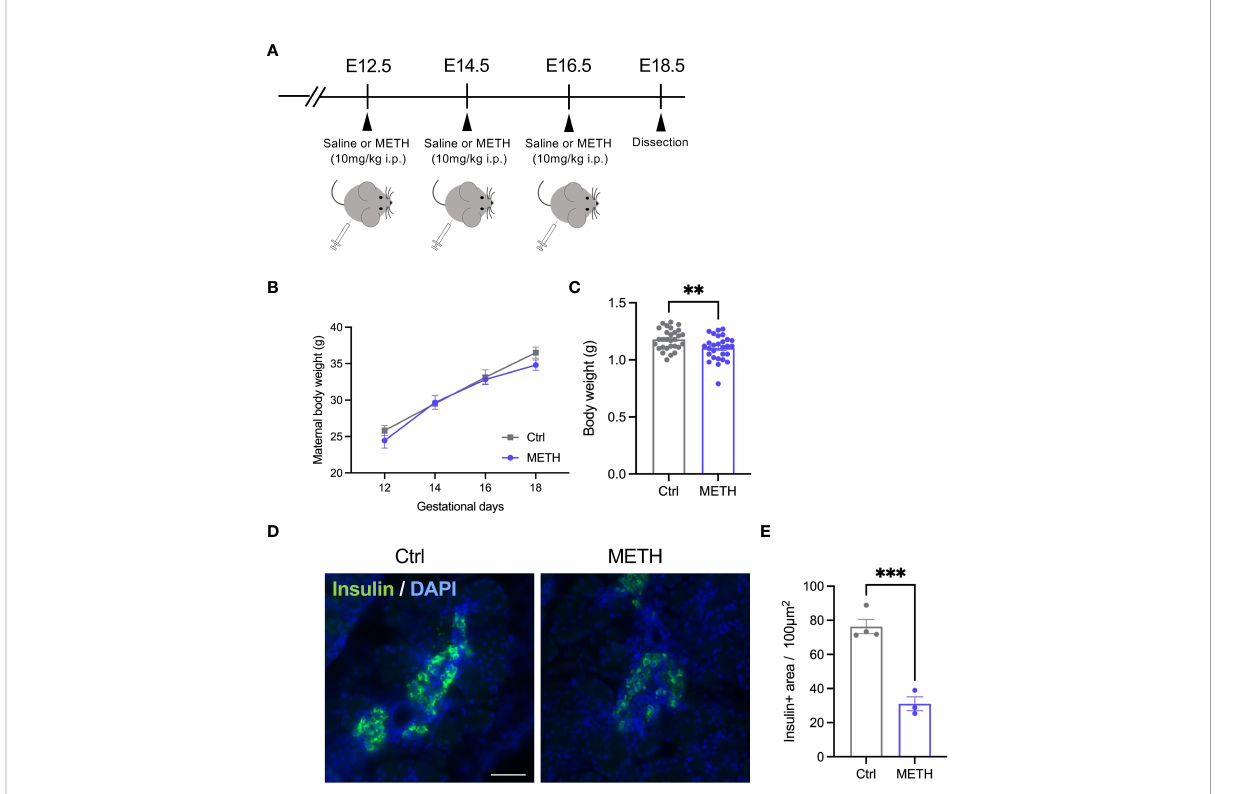
FIGURE 1 Prenatal METH exposure resulted in LBW and insulin production defect in the fetal pancreatic cells. (A) Experimental time course of prenatal METH exposure. METH or saline was administered intraperitoneally at E12.5, E14.5, and E16.5. At E18.5, pregnant mice were dissected. (B) No change in maternal body weight by METH administration. (C) Quanti fi cation of the body weight of offspring at E18.5. The body weight was signi fi cantly reduced in METH-exposed fetus. (D) Representative images of Insulin positive (+) pancreatic b cells. (E) Quanti fi cation of the Insulin + area. Insulin+ area was signi fi cantly decreased in METH-exposed fetal pancreas. Scale bar: 500 m m. Data are represented as means ( ± SEM). **** P < 0.0001, ** P < 0.01, Two-way ANOVA with a Tukey ’ s multiple comparison test, unpaired t -test, n = 4/condition for maternal body weight, n = 28-29/condition for body weight, n = 3-4/condition for Insulin+